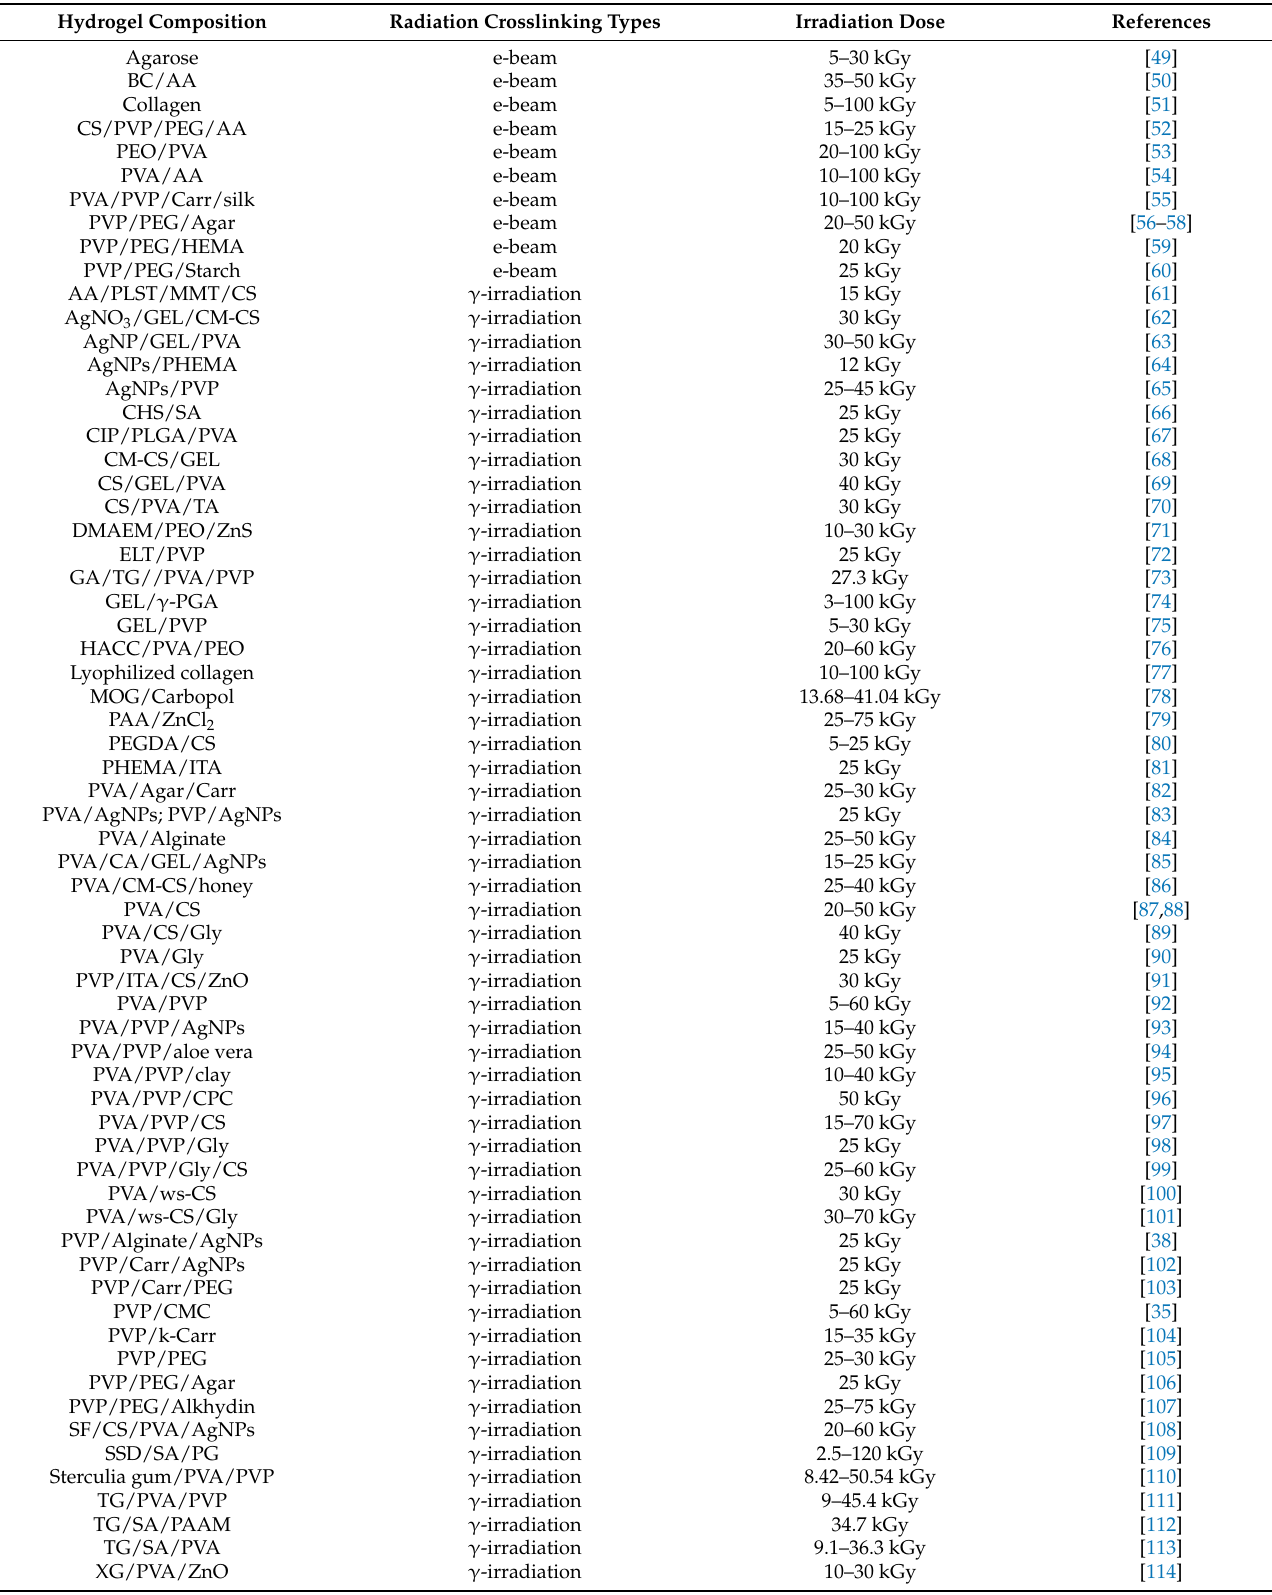
Table 1. Classification of preparation methods and irradiation